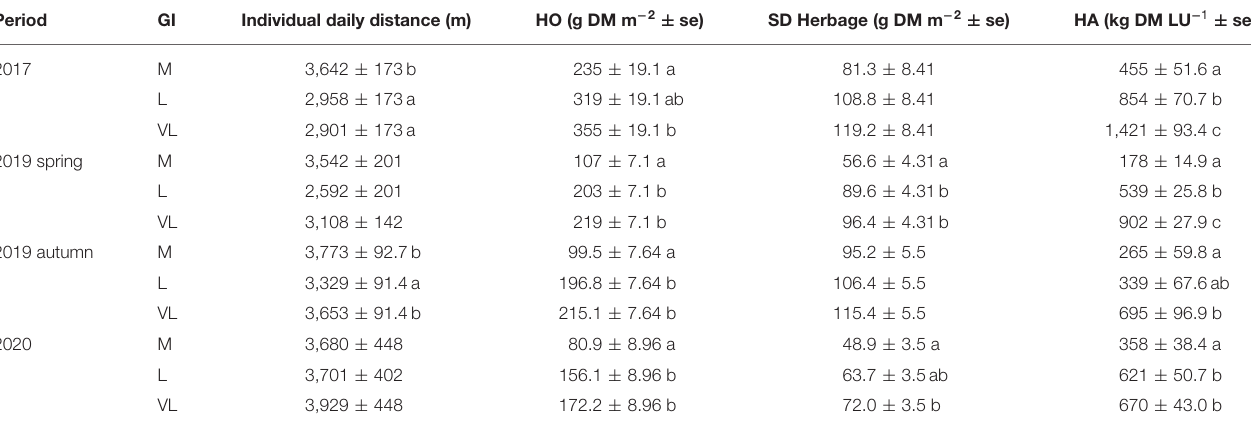
TABLE 4 | Estimated means ± se (standard error) of linear mixed effect models for every period. Period GI Individual daily distance (m) HO (g DM m − 2 ± se) SD Herbage (g DM m − 2 ± se)